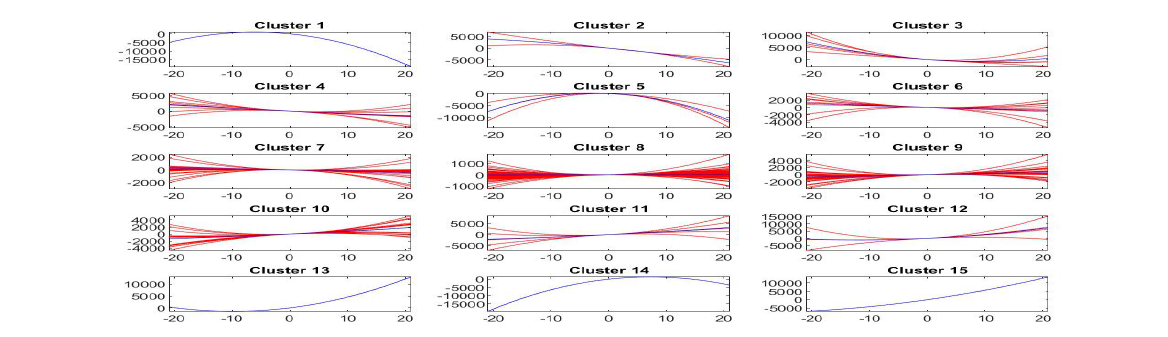
Figure 25. Clustering of L 2 -norm F-transform components (polynomials) of order 2 for Bitcoin series. The fuzzy r -partition is P b with r = 3.